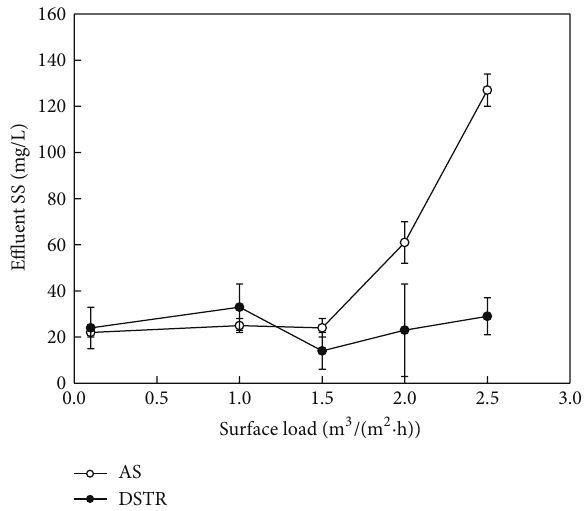
Figure 2: Effluent SS levels of the two reactor types under different surface loads. Surface load was calculated based on the area of the sludge separation tank.